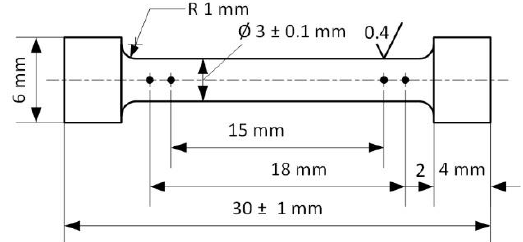
Figure 2. Tensile test specimen sketch-test specimens were manufactured according to GOST 1497—84 (ISO 6892—84).